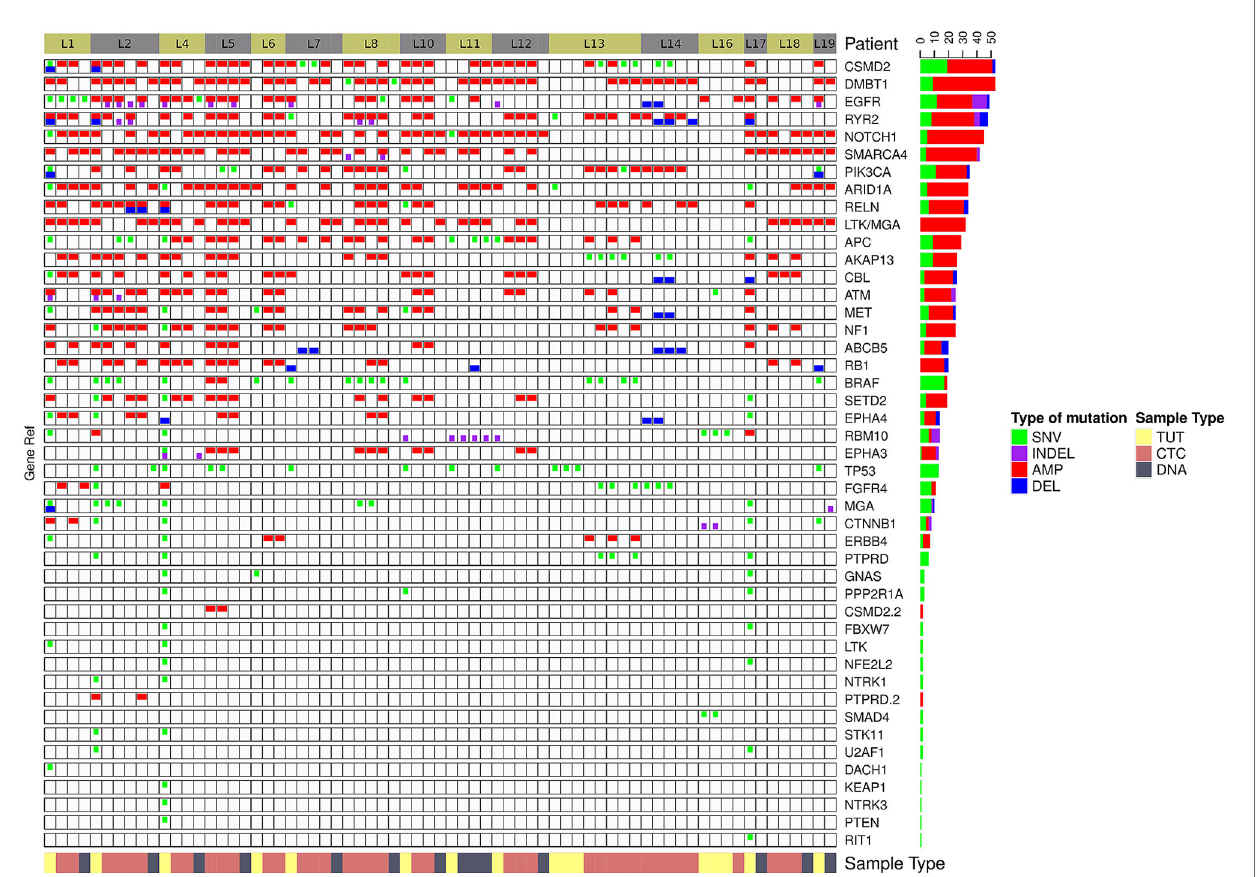
FIGURE 2 | The genomics alteration detected in the lung cancer samples. The tabulation of exonic SNVs, in-frame or frame-shift INDELs and CNVs of frequently mutated genes. The right panel displays the cumulative numbers of alterations for individual genes. Patient ’ s sample IDs are shown at the top panel. The bottom panel shows the type of samples analyzed. Red rectangles represent ampli fi cations. Blue rectangles represent deletions. Green rectangles represent missense, Stopgain or Stoploss somatic SNVs. Purple rectangles represent somatic INDELs. TUT, CTC and DNA refer to tumors, individual CTC and ctDNA